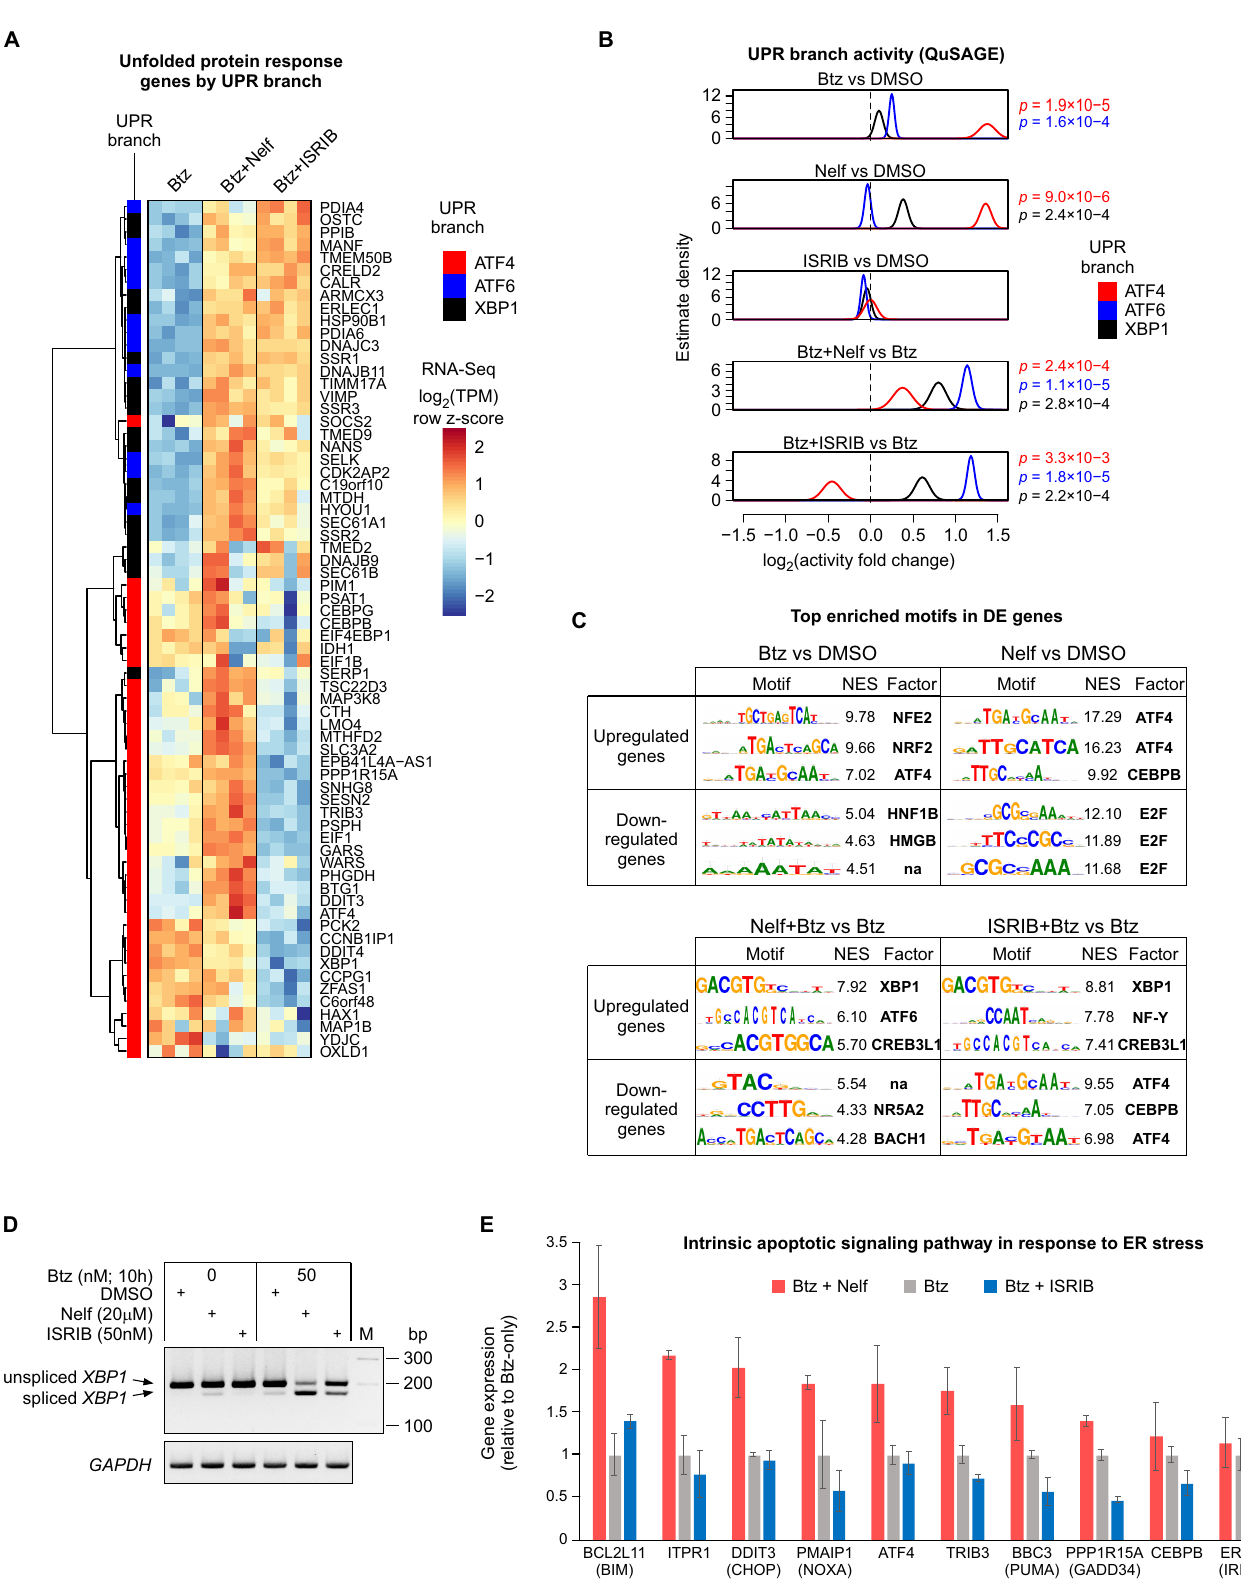
Figure 3. Perturbation of eIF2 α –ATF4 signaling alters the activity of all three branches of the UPR and the expression of pro-apoptotic ER stress response genes. RNA-Seq data from HepG2 cells treated with bortezomib (Btz), nelfinavir (Nelf) and ISRIB (Figure 2). ( A ) Alteration of the Btz response by co-treatment with Nelf or ISRIB. Genes previously assigned to one of the three UPR branches (ATF4, ATF6 or XBP1) were included in the heatmap. Each column corresponds to an independent library. ( B ) The calculated activity of individual branches of the UPR at the gene set level. Genes were